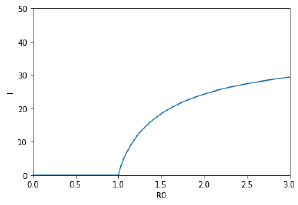
Figure 4. Forward bifurcation diagram of the endemic equilibrium near (cid:60) 0 = 1 and the disease-free point E 0 . It means, the endemic equilibrium exists if and only if (cid:60) 0 > 1. We have used the Equation (3.5) to plot the graph by writing the coefficients A i in terms of (cid:60) 0 as much as possible. The bifurcation parameter can be any of the parameters involved in (cid:60) 0 . The implication of the occurrence of forward bifurcation means that the disease can be eradicated if (cid:60) 0 is less that one.